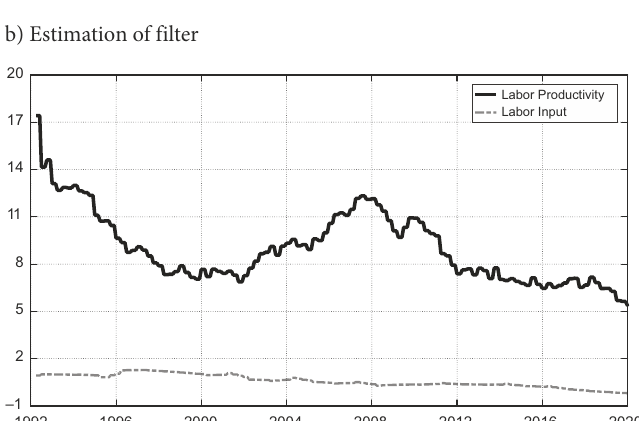
Figure 7. Two-factor decomposition of the trend using annual total employment as the proxy variable for labor force